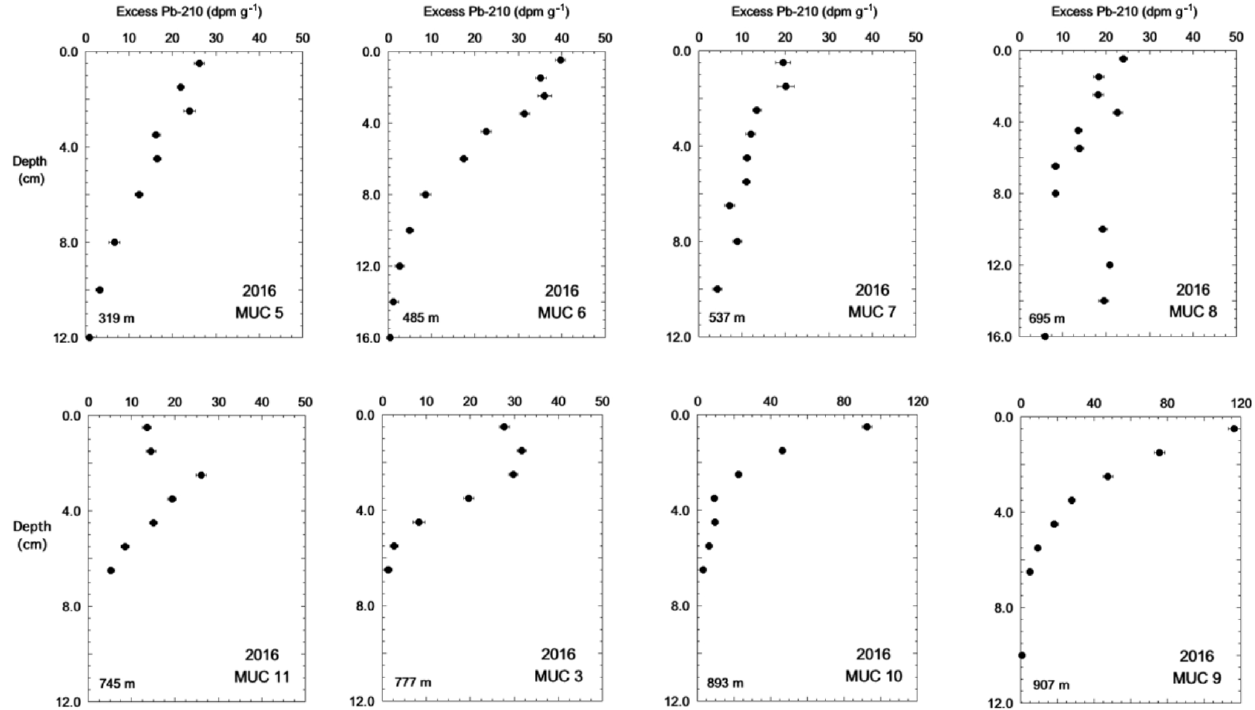
Figure 7. Eight multicores sampled for 210 Pb in the Santa Monica Basin. The points are plotted in the middle of the depth interval (given in Table 2). Note that the depth and activity scales are different for different